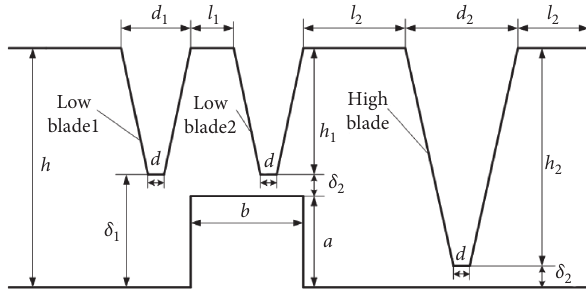
Figure 2: Local view of the staggered labyrinth seal. Table 1: Seal dimensions.